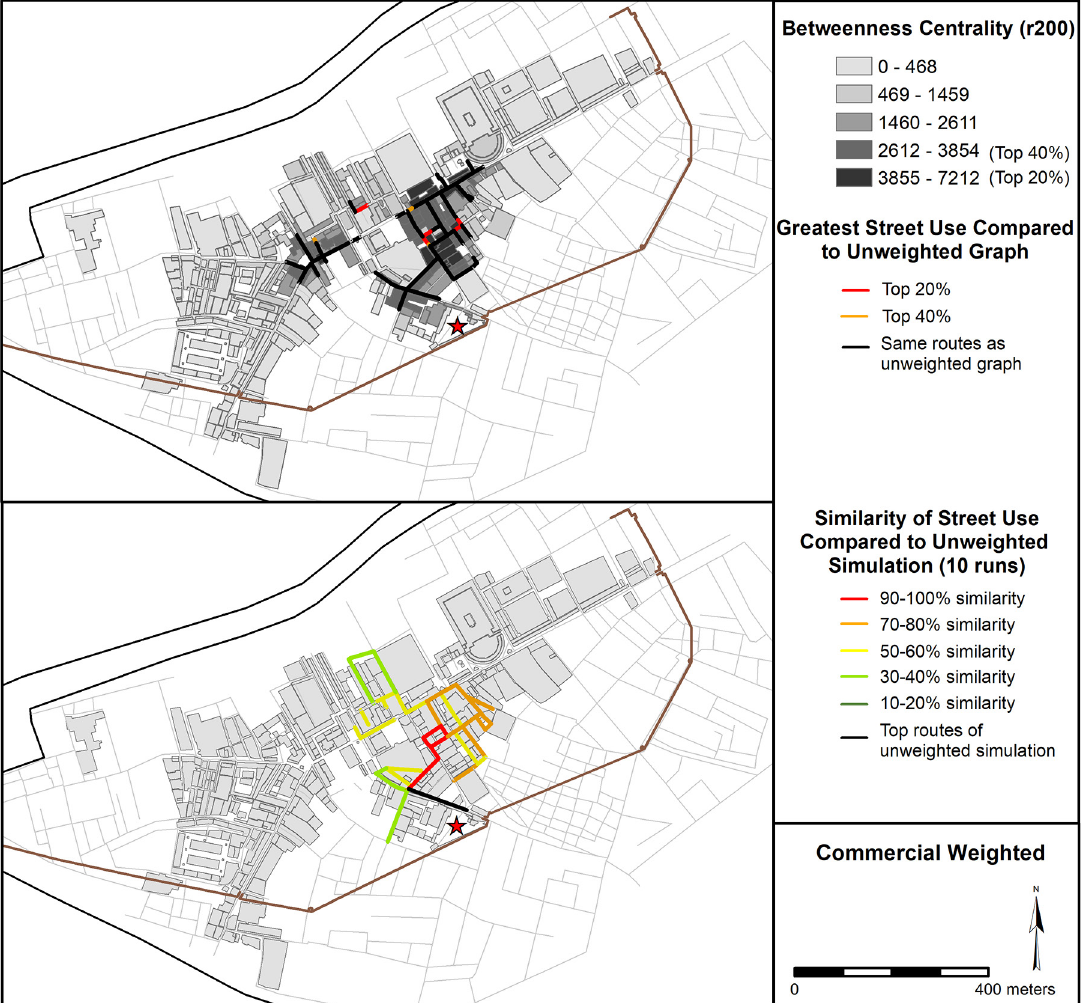
Figure 8. Top: Betweenness centrality graph weighted by commercial buildings. Streets displayed in red and orange follow the highest betweenness centrality metrics which are different from the unweighted graph. Bottom: Similarity of street usage by processional runs weighted by commercial